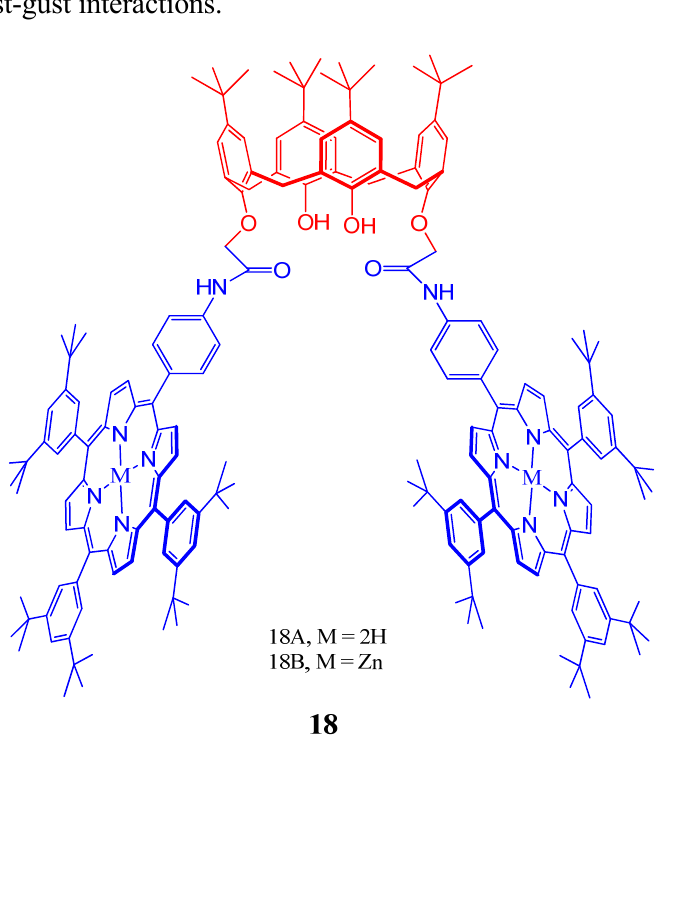
Figure 19. Calixarene-bisporphyrins system ( 18 ) capable of achieving electronic charge transfer during host-gust